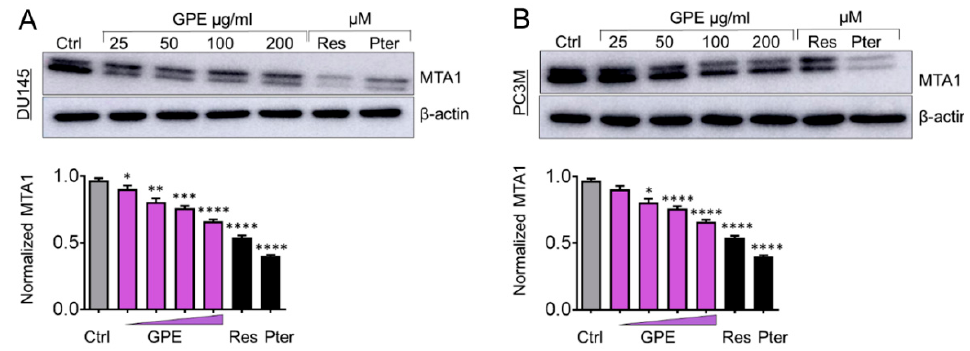
Figure 4. GPE inhibits MTA1 protein expression in a dose-dependent manner in DU145 and PC3M prostate cancer cells. Immunoblots of MTA1 expression in ( A ) DU145 and ( B ) PC3M cells (top panels). β -actin was used as a loading control. Western blots were repeated three times and representative blots are shown. Quantitation of immunoblot signals (lower panels). * p < 0.05, ** p < 0.01, *** p < 0.001, and **** p < 0.0001 (one-way ANOVA) were assessed as significant differences between treated and Ctrl vehicle cells.